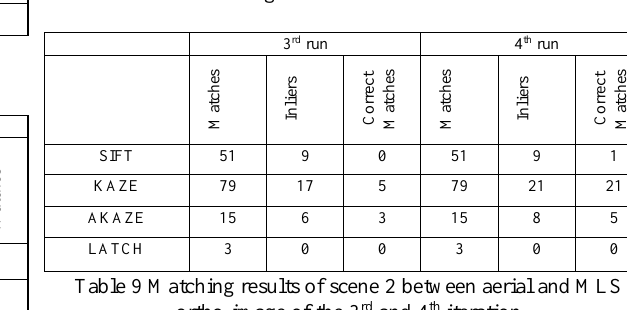
Table 9 Matching results of scene 2 between aerial and MLS ortho-image of the 3 rd and 4 th